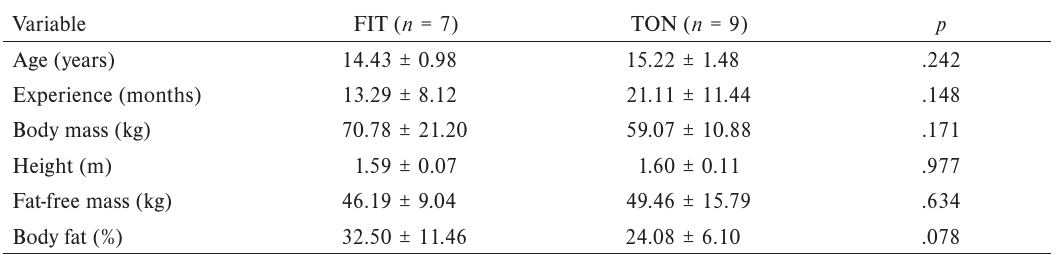
Physical characteristics (M ± SD) of participants in isokinetic (FIT) and isotonic (TON) groups at pre-test Variable